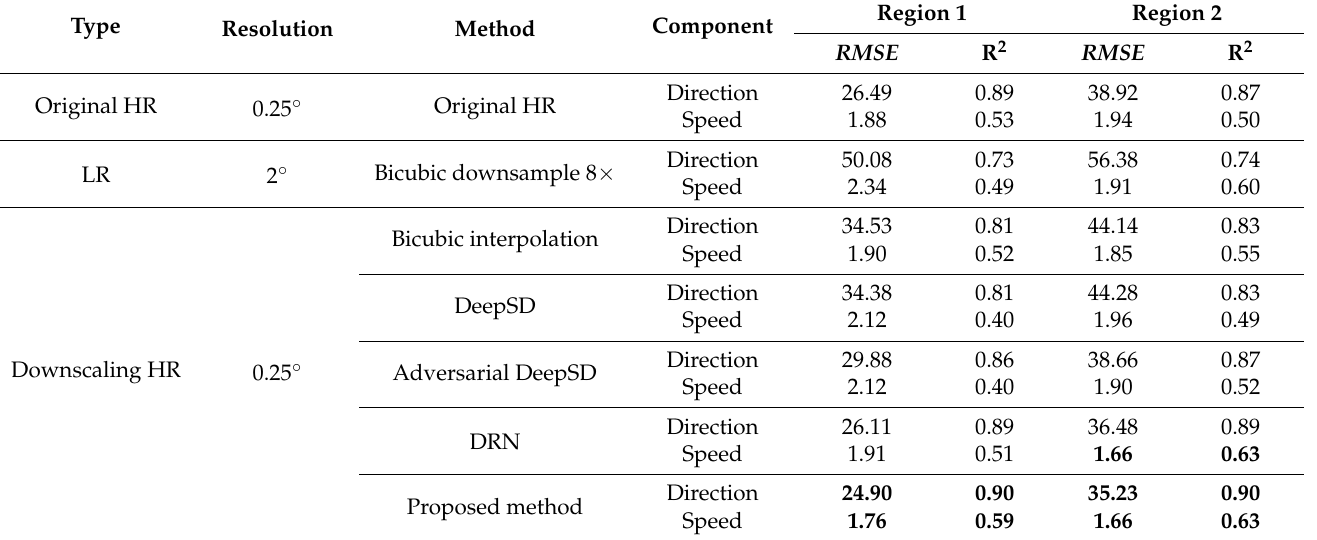
Table 3. Accuracy validation of sea surface wind downscaling with buoy measurements in terms of RMSE and R 2 on the test dataset for the study areas in Figure 1.